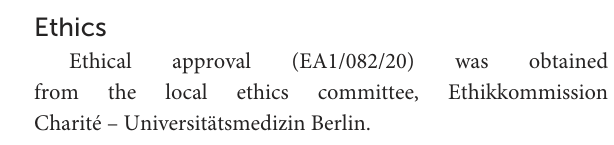
on November 2, 2020 (25). On May 20, 2021 shutdown measures were mostly lifted in Berlin, Germany, which marks the endpoint of the pandemic period in our analyses (Figure 1). March 2020 was excluded from the analyses to allow a clear discrimination between the control and pandemic